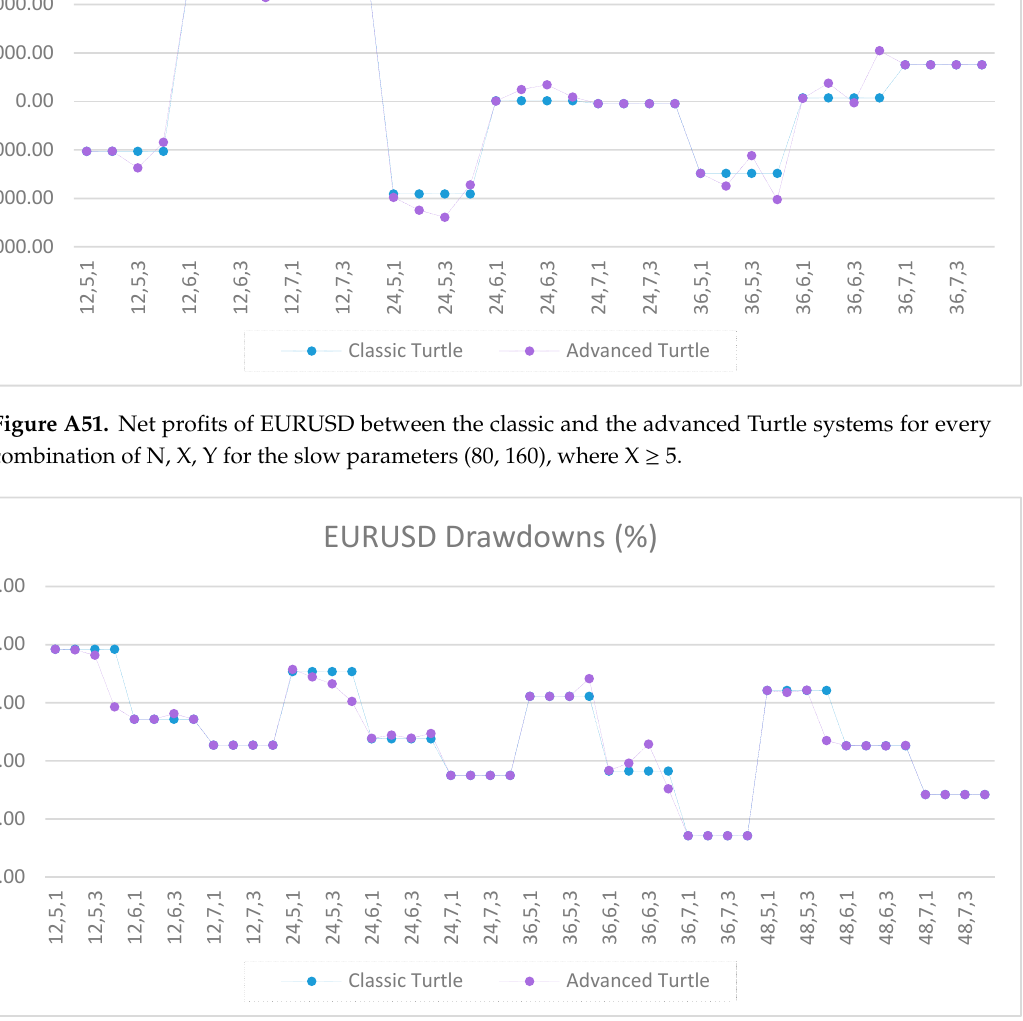
Figure A52. Drawdowns of EURUSD as percentage of equity between the classic and the advanced Turtle systems for every combination of N, X, Y for the slow parameters (80, 160), where X ≥ 5.